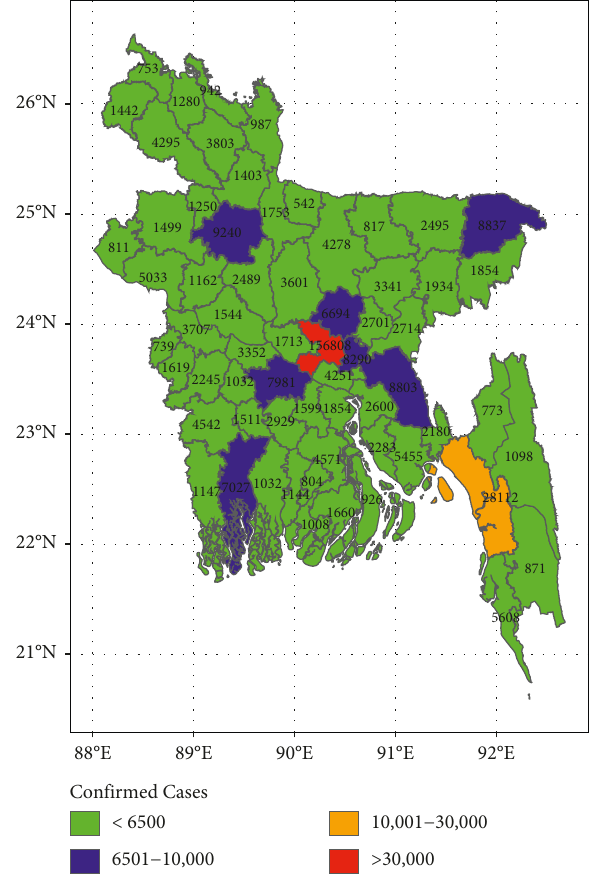
Figure 2: The COVID-19 hotspot map based on the clustering of districts regarding COVID-19 cases in Bangladesh.